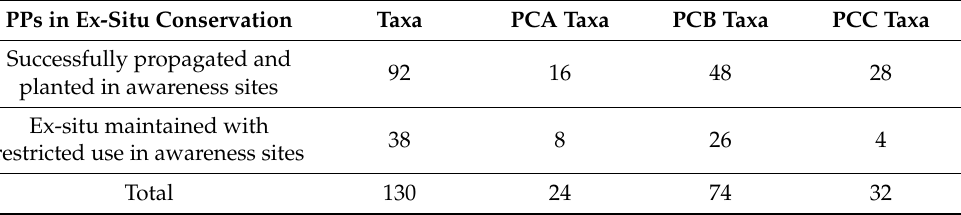
Table 1. Overview of plant taxa of different conservation priority categories (PCA, Threatened and Near Threatened; PCB, Local Balkan endemics and subendemics; PCC, Regionally rare and/or uncommon plants) used in different awareness-raising sites after ex-situ propagation and acclimatization.